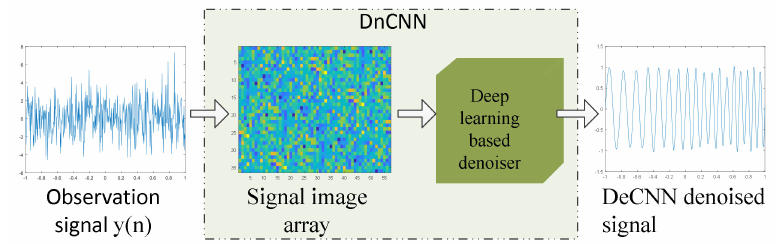
Figure 2. Overview of DnCNN.